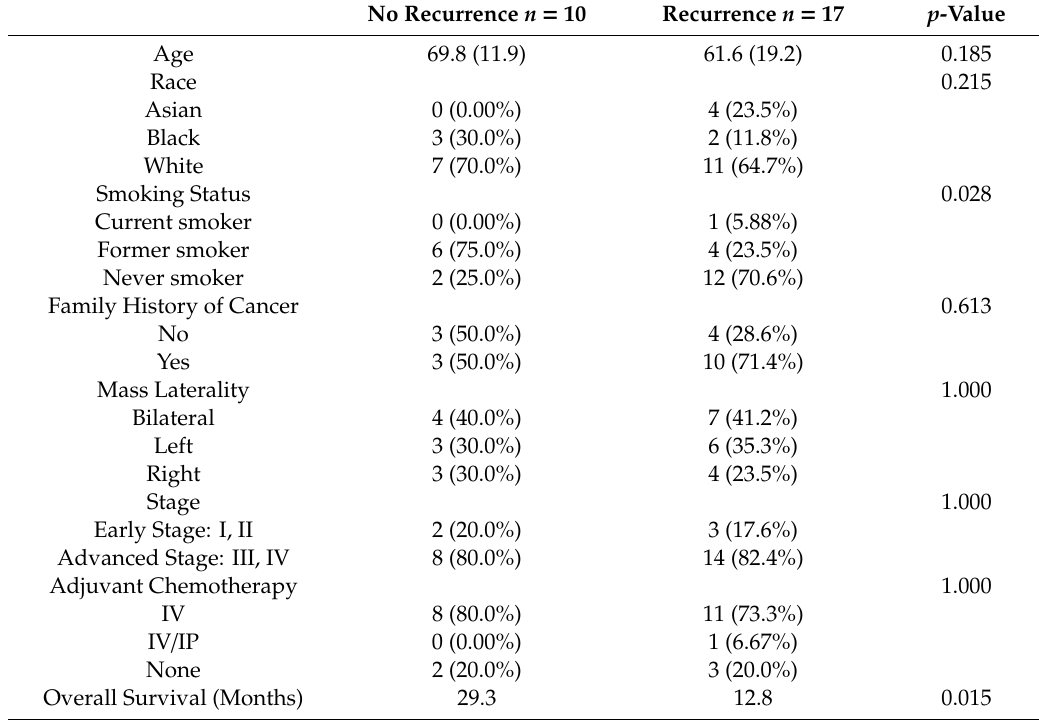
Figure 3. Overall survival by stage. Kaplan–Meier curve comparing early stage (I and II) to advanced stage (III and IV). Table 2. Demographic information based on recurrence